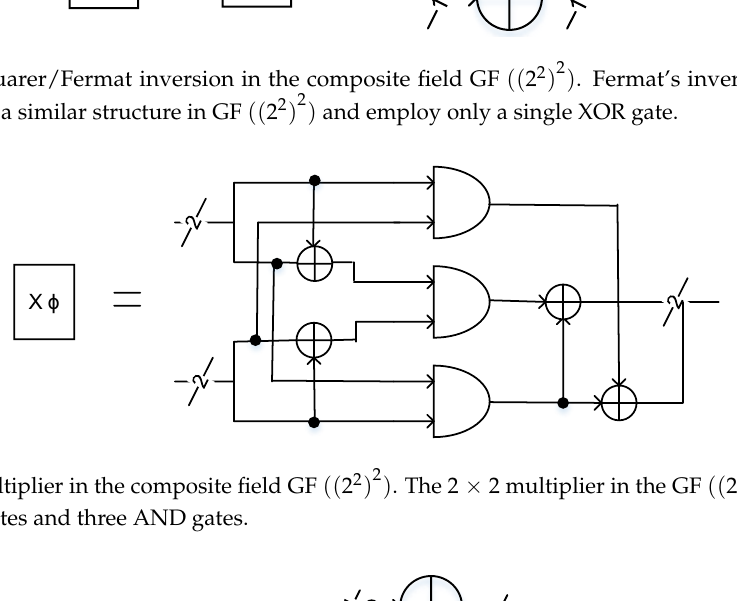
Figure 5. Multiply with constant ∅ = 10 2 . The constant multiplier employs only a single XOR gate in GF((2 2 ) 2 ) . Table 1. Symbolic representation of the substructures